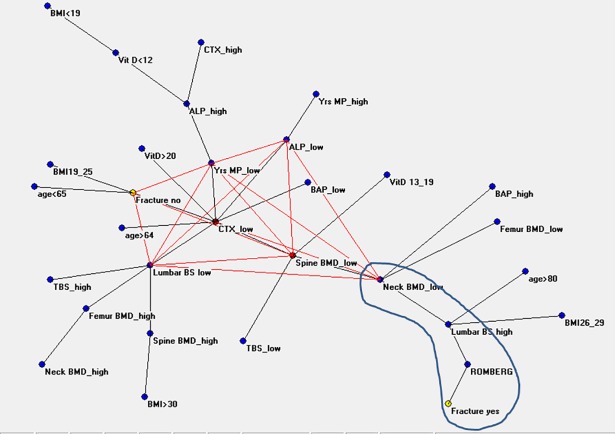
Maximal Regular Graph of the investigated anagraphic, antropometric, densitometric, biochemical and clinical parameters.